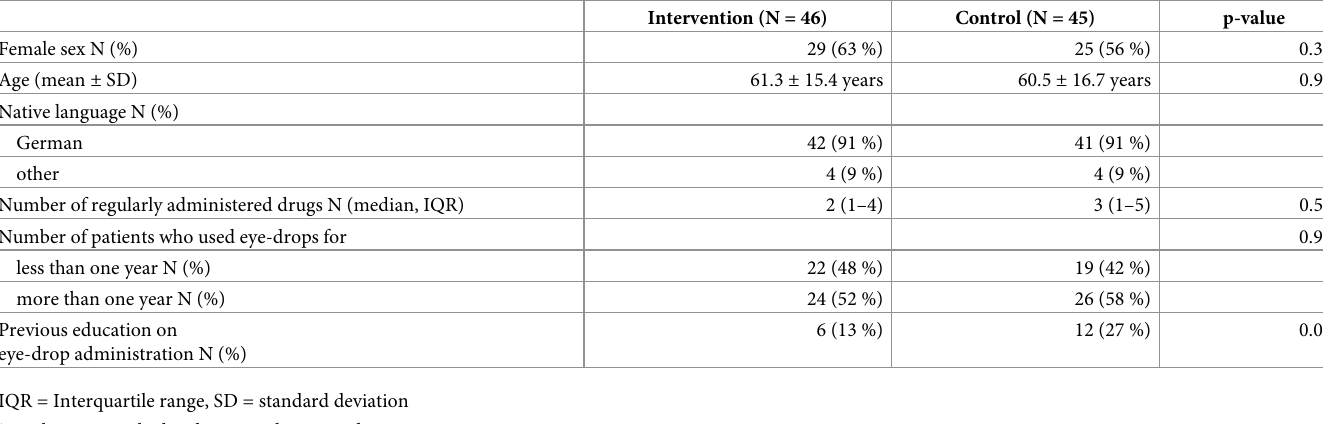
Table 2. Demographic data of study participants invited to follow-up